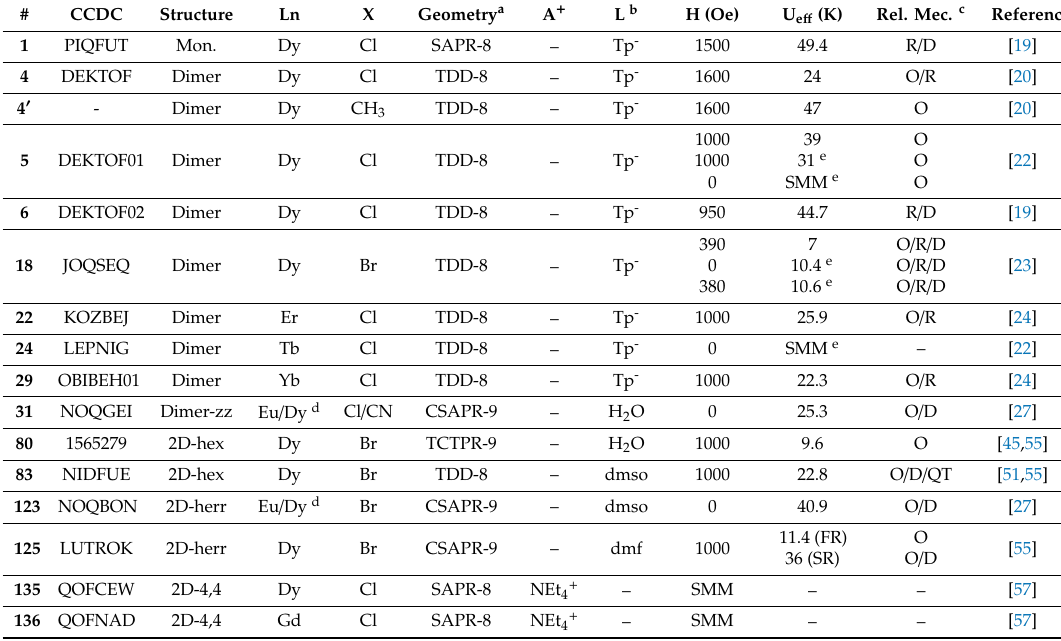
Table 28. Ln-anilato compounds with slow relaxation of the